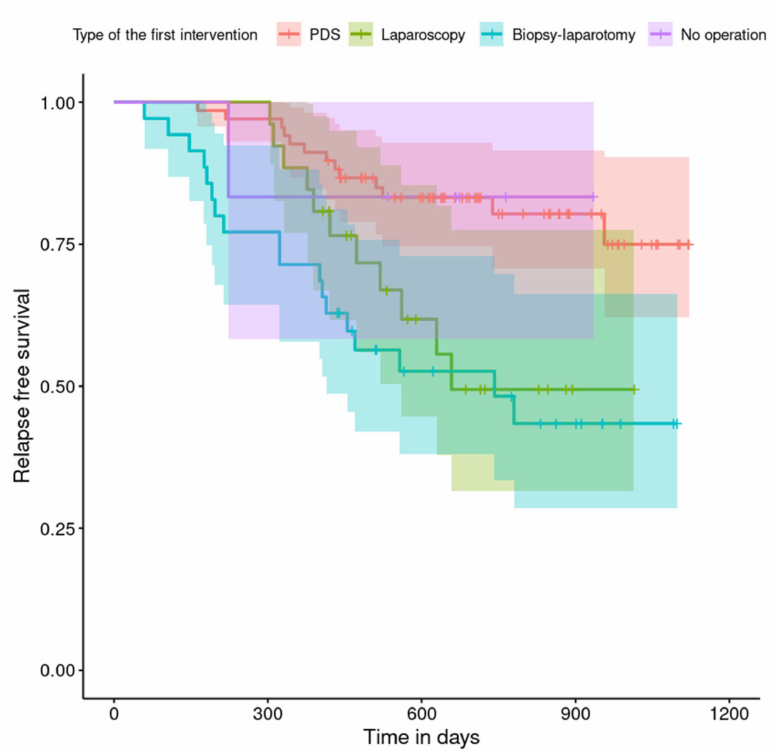
Figure 6. Relapse-free survival curve with 95% CI (darkened area) broken down by type of the first intervention.